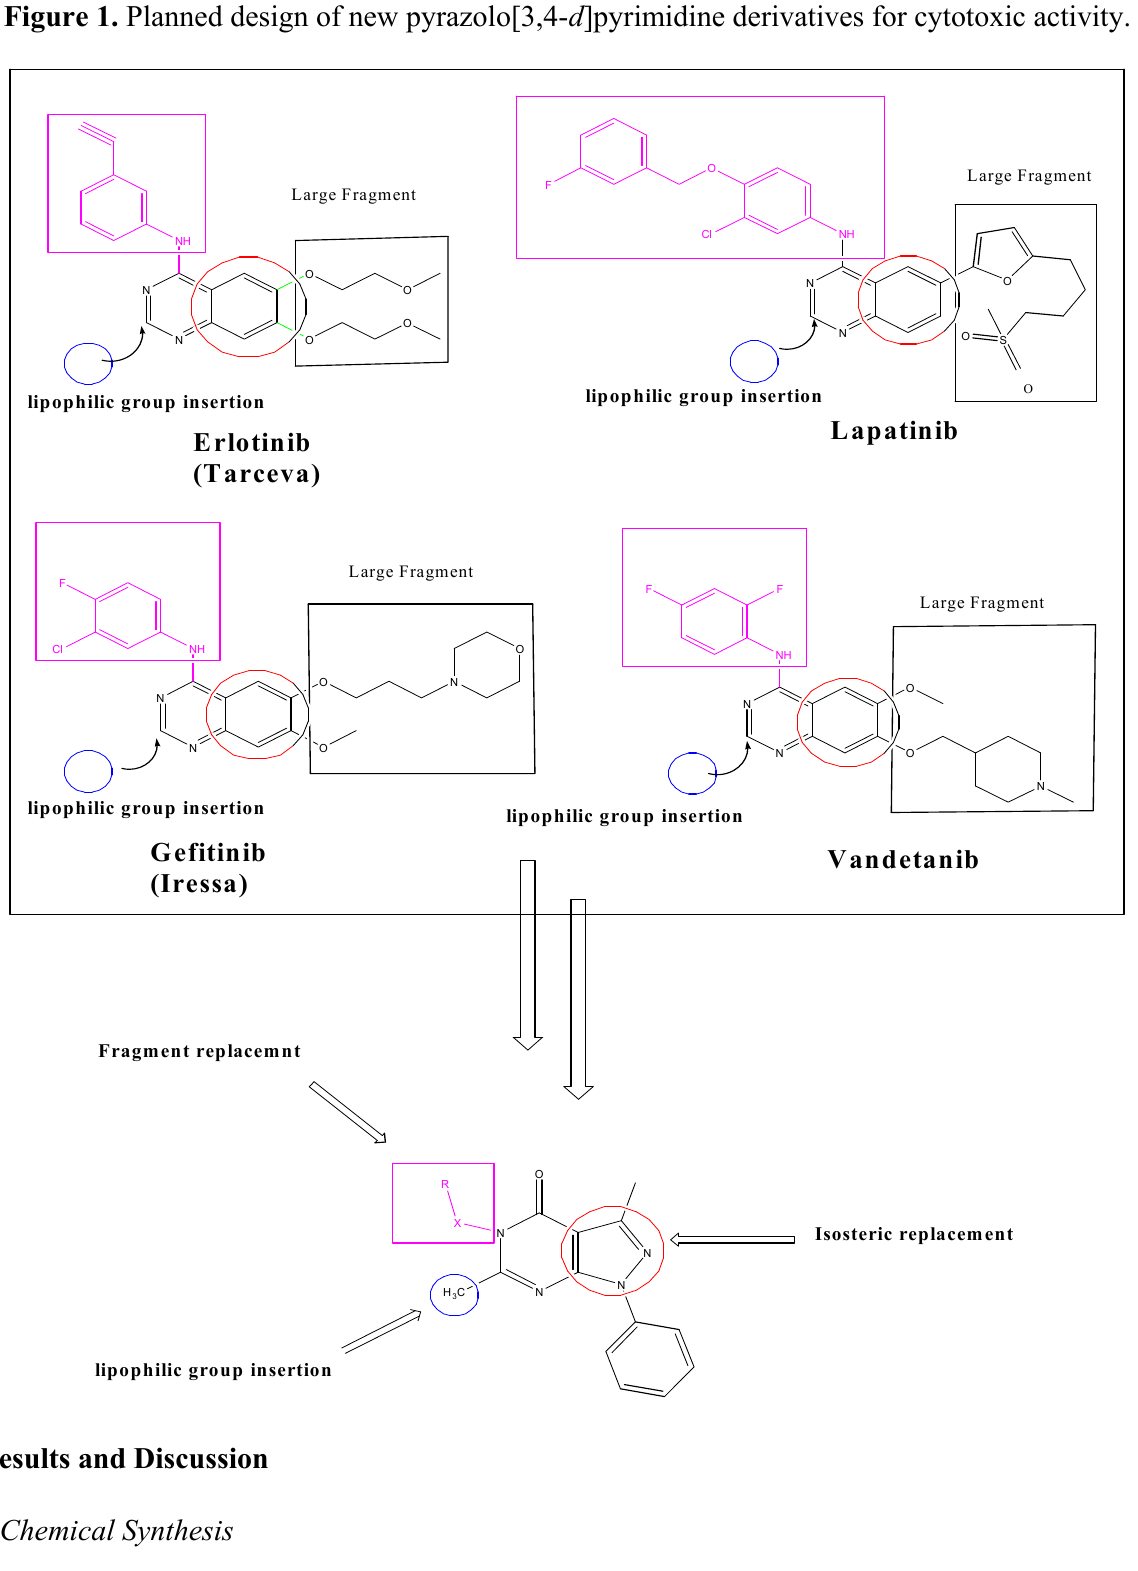
Figure 1. Planned design of new pyrazolo[3,4- d ]pyrimidine derivatives for cytotoxic